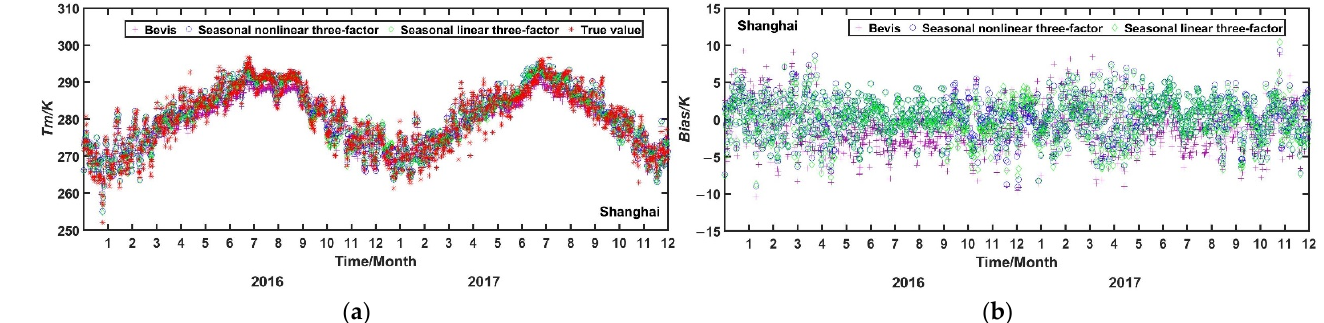
Figure 11. Time series of 𝑇 (cid:3040) ( a ) and the biases ( b ) of Bevis, linear and nonlinear seasonal three- factor RTMs to the radiosonde-derived 𝑇 (cid:3040) at Shanghai station during 2016–2017. RTMs to the radiosonde-derived T m at Shanghai station during 2016–2017. Table 12. The biases and RMSE of the linear and nonlinear seasonal multifactor RTMs-derived 𝑇 (cid:3040) in the Yangtze River Delta region during 2016–2017 (K).